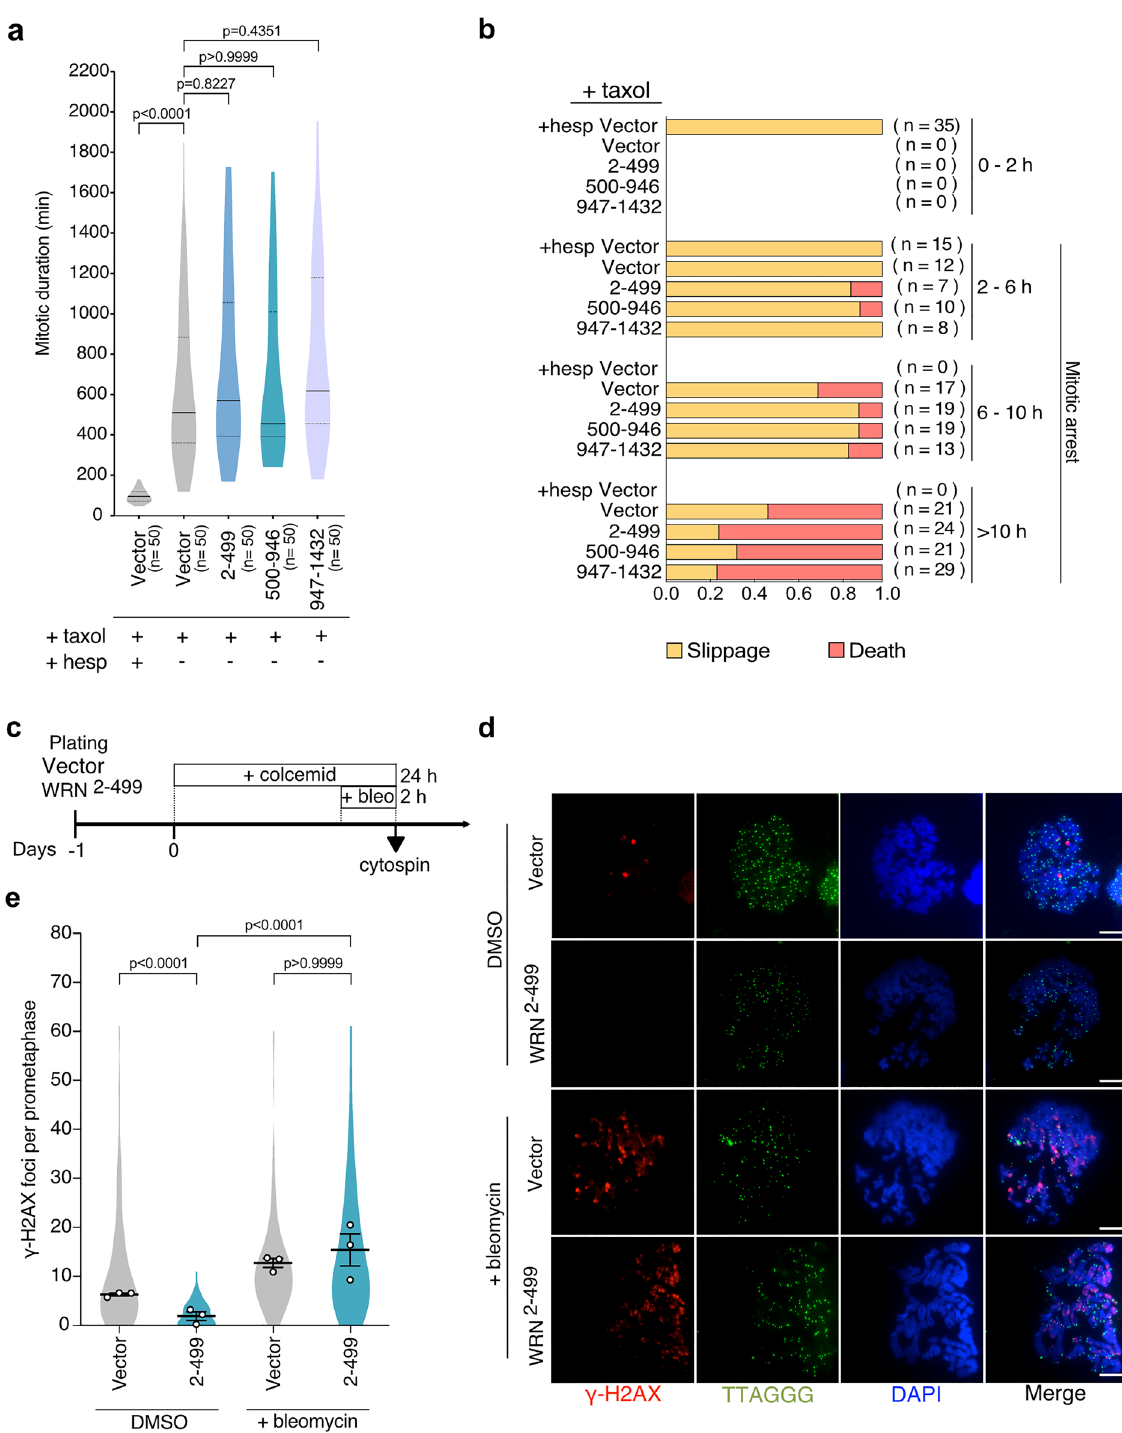
Figure 3. WRN N-terminus does not perturb mitotic Aurora B or ATM kinase activities. ( a ) Distribution of mitotic duration in cells expressing indicated WRN fragments (Median, 25th, and 75th percentile; Kruskal– Wallis followed by Dunn’s test). Cells were exposed to 500 nM taxol and analyzed by live-cell imaging data. Vector cells were co-treated with 40 nM Hesperadin as a control. ( b ) Ratio of each cell fate after mitosis in indicated cells. Results are separately shown as categorized by the duration of mitotic arrest. Mitosis longer than 2 h was defined as mitotic arrest. ( c ) Schematic of the timing of 100 ng/ml colcemid and 0.2 µg/ml bleomycin treatment in IMR-90 E6E7 hTERT cells expressing NLS-4xFL-WRN 2–499 fragment. ( d ) Representative images of γ-H2AX foci on mitotic chromosomes in cells treated as in ( c ). Images show DAPI (blue), γ-H2AX (red), and telomere FISH (green). Scale bar, 10 µm. ( e ) Quantification of total γ-H2AX foci on mitotic chromosomes. Violin plots illustrate the distribution of all data and averages from three independent experiments (n = 30/ experiment; mean ± s.e.m.; Kruskal–Wallis followed by Dunn’s